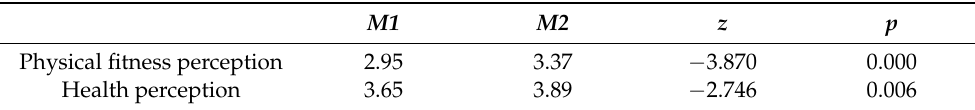
Table 4. Wilcoxon